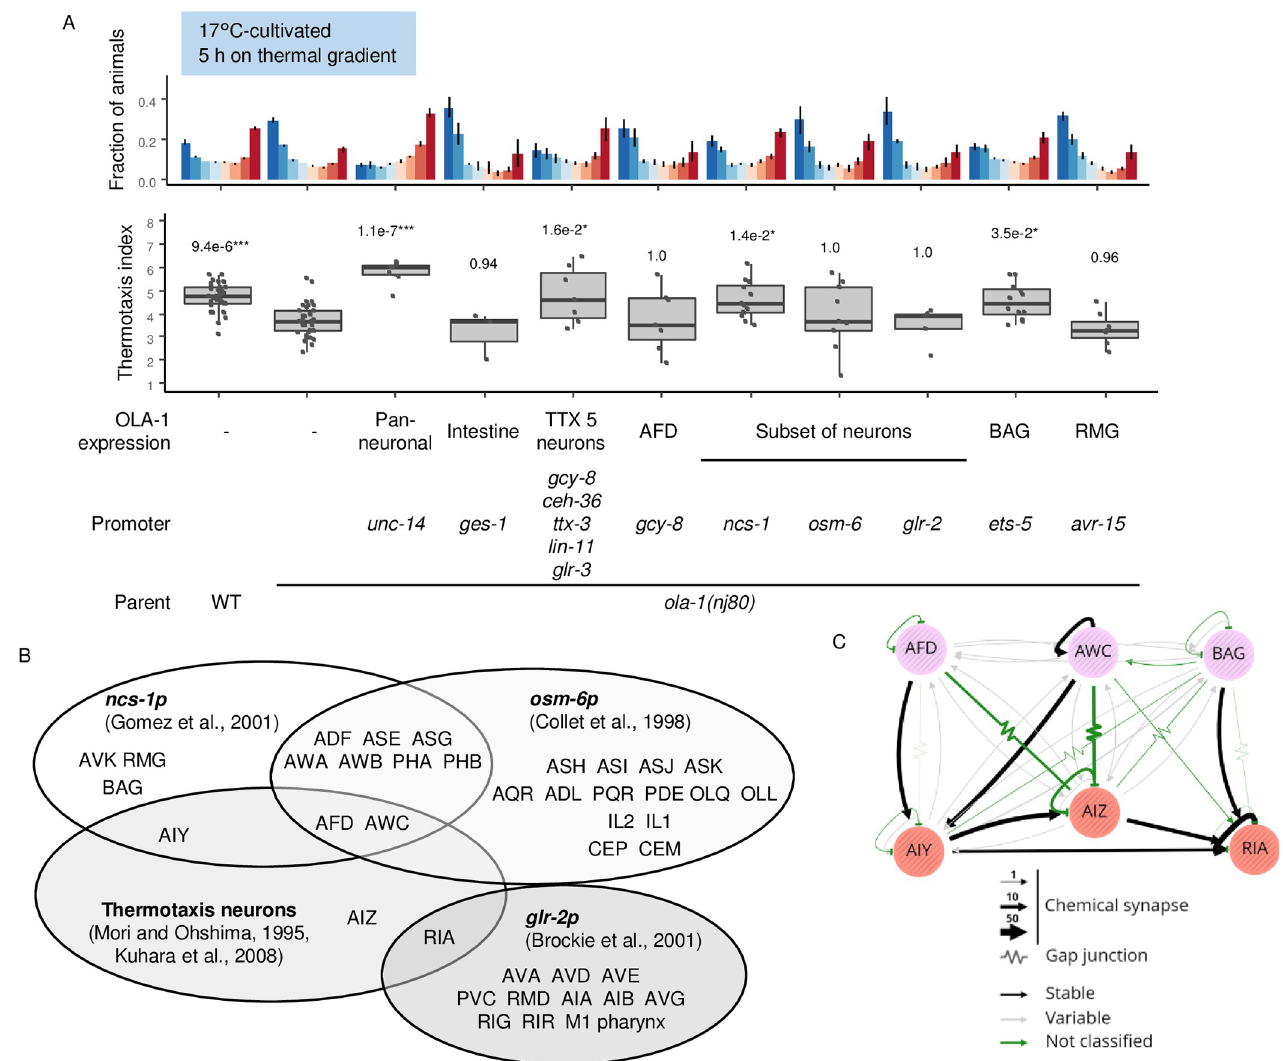
Fig 4. ola-1 acts in multiple neurons when animals are cultivated at 17˚C. (A) Wild type and ola-1(nj80) animals and ola-1(nj80) animals that express OLA- 1 in the cells or tissues indicated were cultivated at 17˚C for 5 days and allowed to freely migrate on a thermal gradient for 5 h. n = 36, 37, 7, 3, 7, 7, 12, 9, 5, 12, 7. p values are indicated (Dunnett test against ola-1(nj80) animals). (B) Neurons where each gene promoter induces gene expression. (C) Connections of indicated neurons were visualized by NemaNode (https://bit.ly/3BSnHAj)